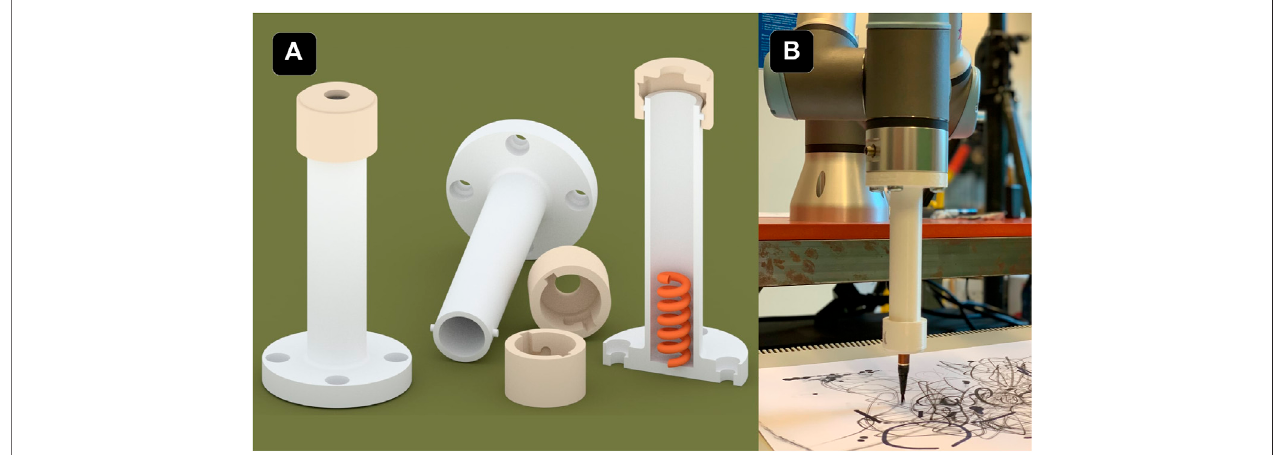
FIGURE3|(A) 3Drepresentationofthreeoftheobjectsusedasanendeffectortoattachdifferentdrawingtools,suchasmarkersorbrushes.Itcontainsasprintin the bottom to adjust the tool. The object at the right is cut in half to display the inside. (B) Image of the end effector with ink brush attached to the UR3.